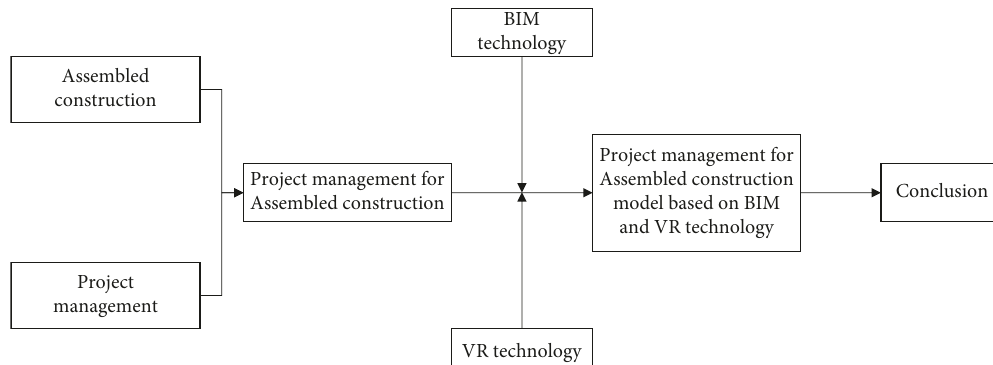
Figure 2: Technical framework of this research.